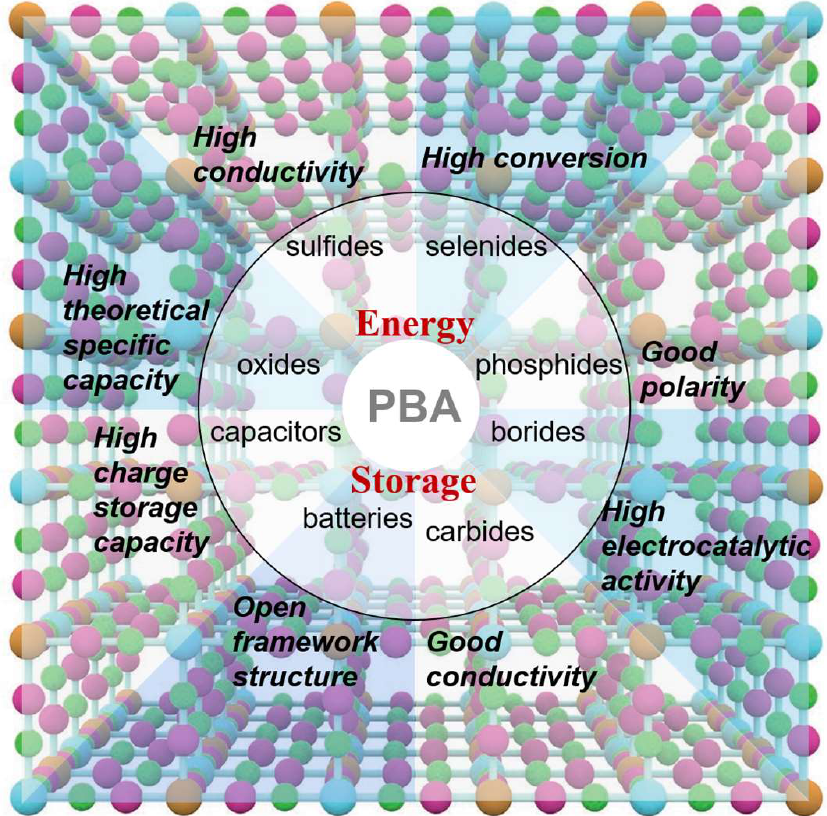
Figure 1. Schematic Diagram of PBA Application in Energy Storage Materials.